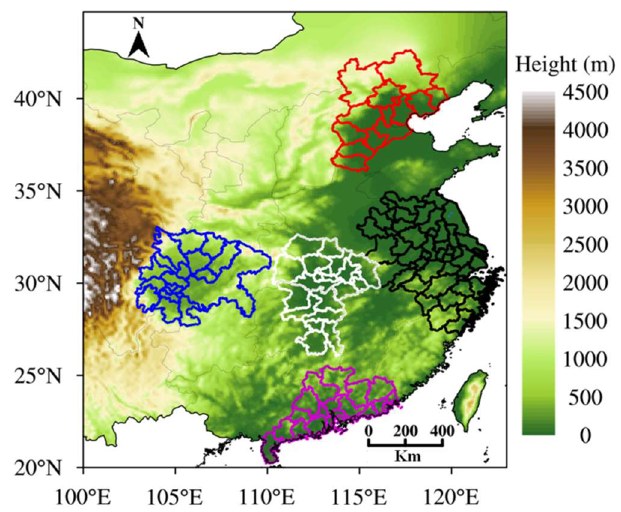
Figure 1. Topographical height (m, in a.s.l) of Central and Eastern China (CEC), with the red, black, white, blue, and purple lines marking the regions of the North China Plain (NCP), Yangtze River Delta (YRD), Twain-Hu Basin (THB), Sichuan Basin (SB), and Pearl River Delta (PRD), respectively, for air pollution change.